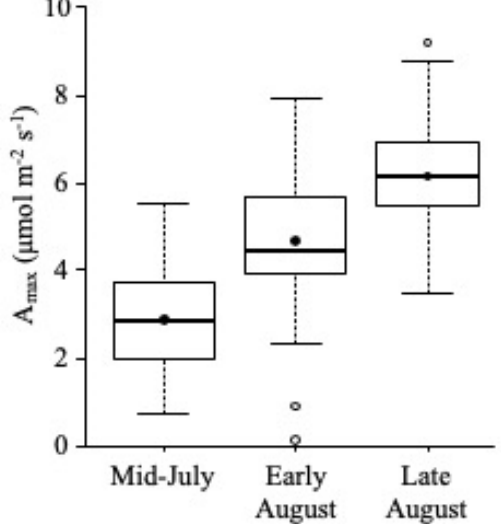
Figure 4. Evolution of A max during the growing season. Solid points and letters represent, respectively, the mean and the significant differences from the 5% threshold (Tukey test).